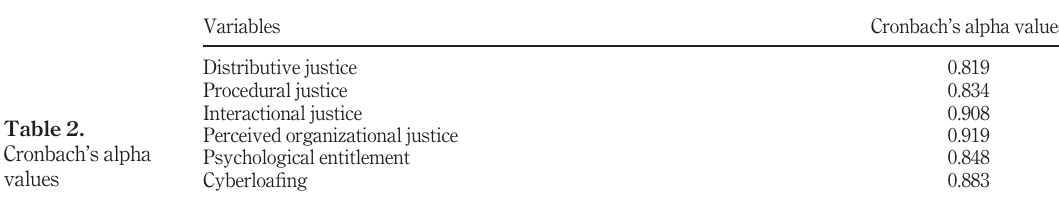
Table 2. Cronbach ’ s alpha